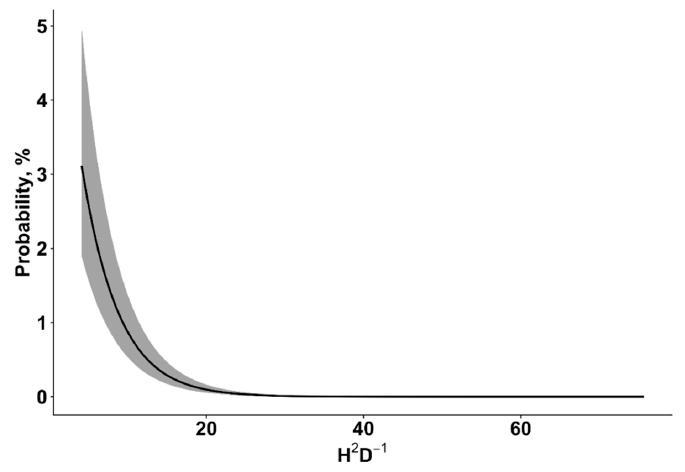
Figure 3. The influence of the slenderness ratio on the probability of wind damage. The grey area represents the ±95% credibility interval.